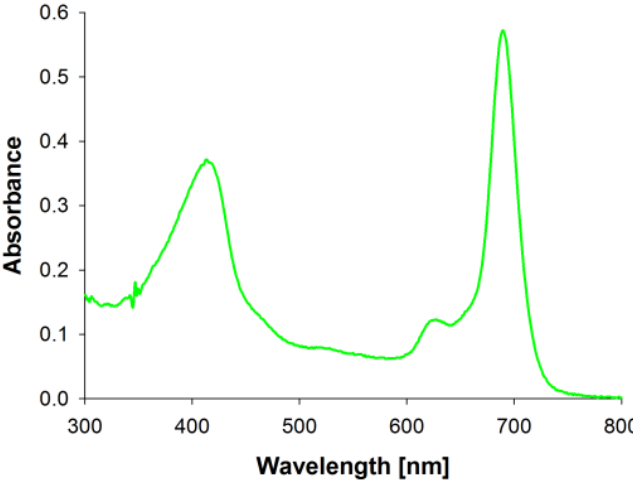
Figure 5. The absorption spectrum of studied compound 2 in DMF. Tetrapyrazinoporphyrazine derivative 2 revealed low solubility in DMF and DMSO,